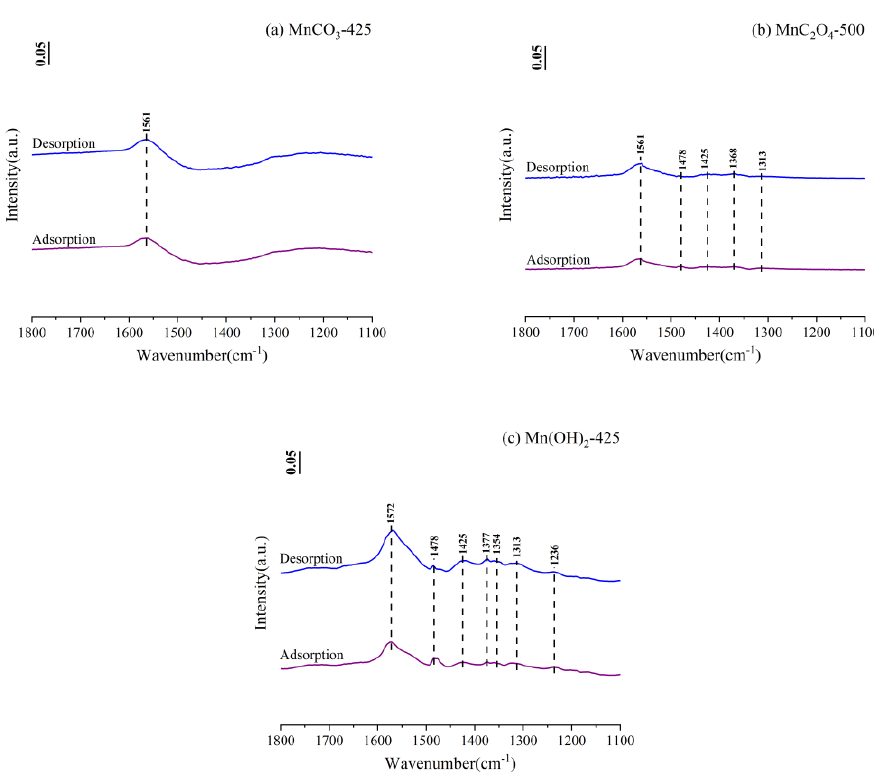
Figure 8. In-situ FTIR spectra of the adsorption and desorption process of the ( a ) MnCO 3 -425 ( b ) MnC 2 O 4 -500 ( c ) Mn(OH) 2 -425 catalysts collected at 100 °C after 30 min on a 1000 ppm benzene/20 vol.% O 2 / N 2 stream followed by exposure of the adsorbed species to a flowing 20 vol% O 2 / N 2 stream.